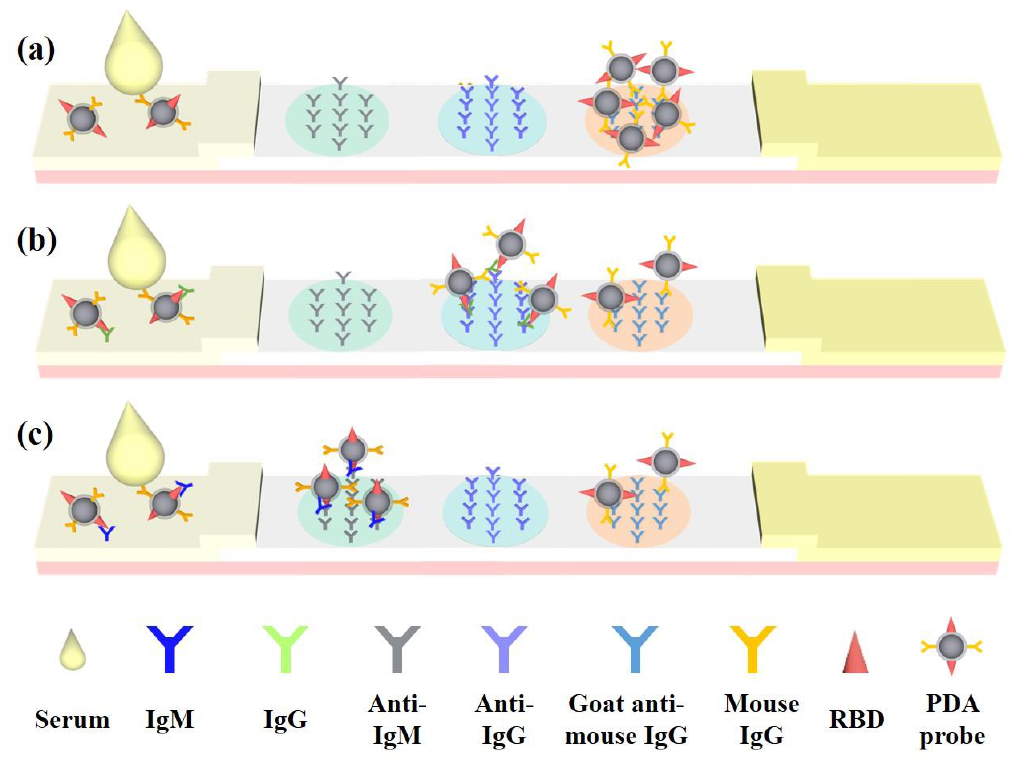
Figure 1. Detection principle of PDA-based three-line LFIA without targets ( a ) or with IgG ( b ) and IgM ( c ) in the serum, respectively.